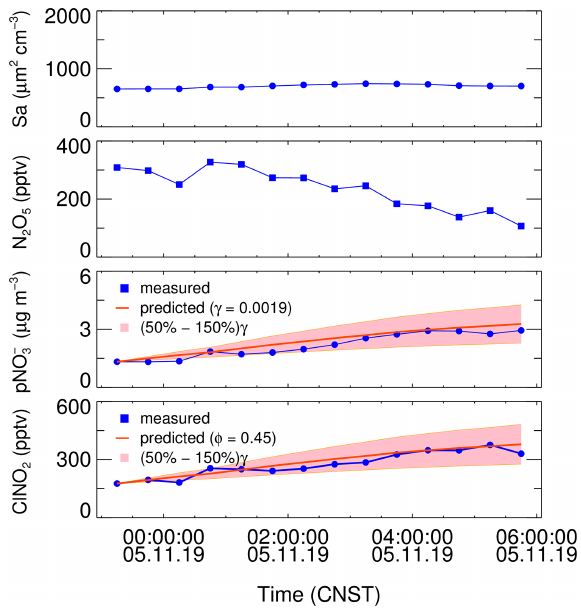
Figure 4. An example of the derivation of the N 2 O 5 uptake coeffi- cient and ClNO 2 yield constrained by observation of aerosol surface area, N 2 O 5 , and the enhancement of particulate nitrate and ClNO 2 on 5 November 2019. The pink region represents ± 50% uncertainty of N 2 O 5 uptake